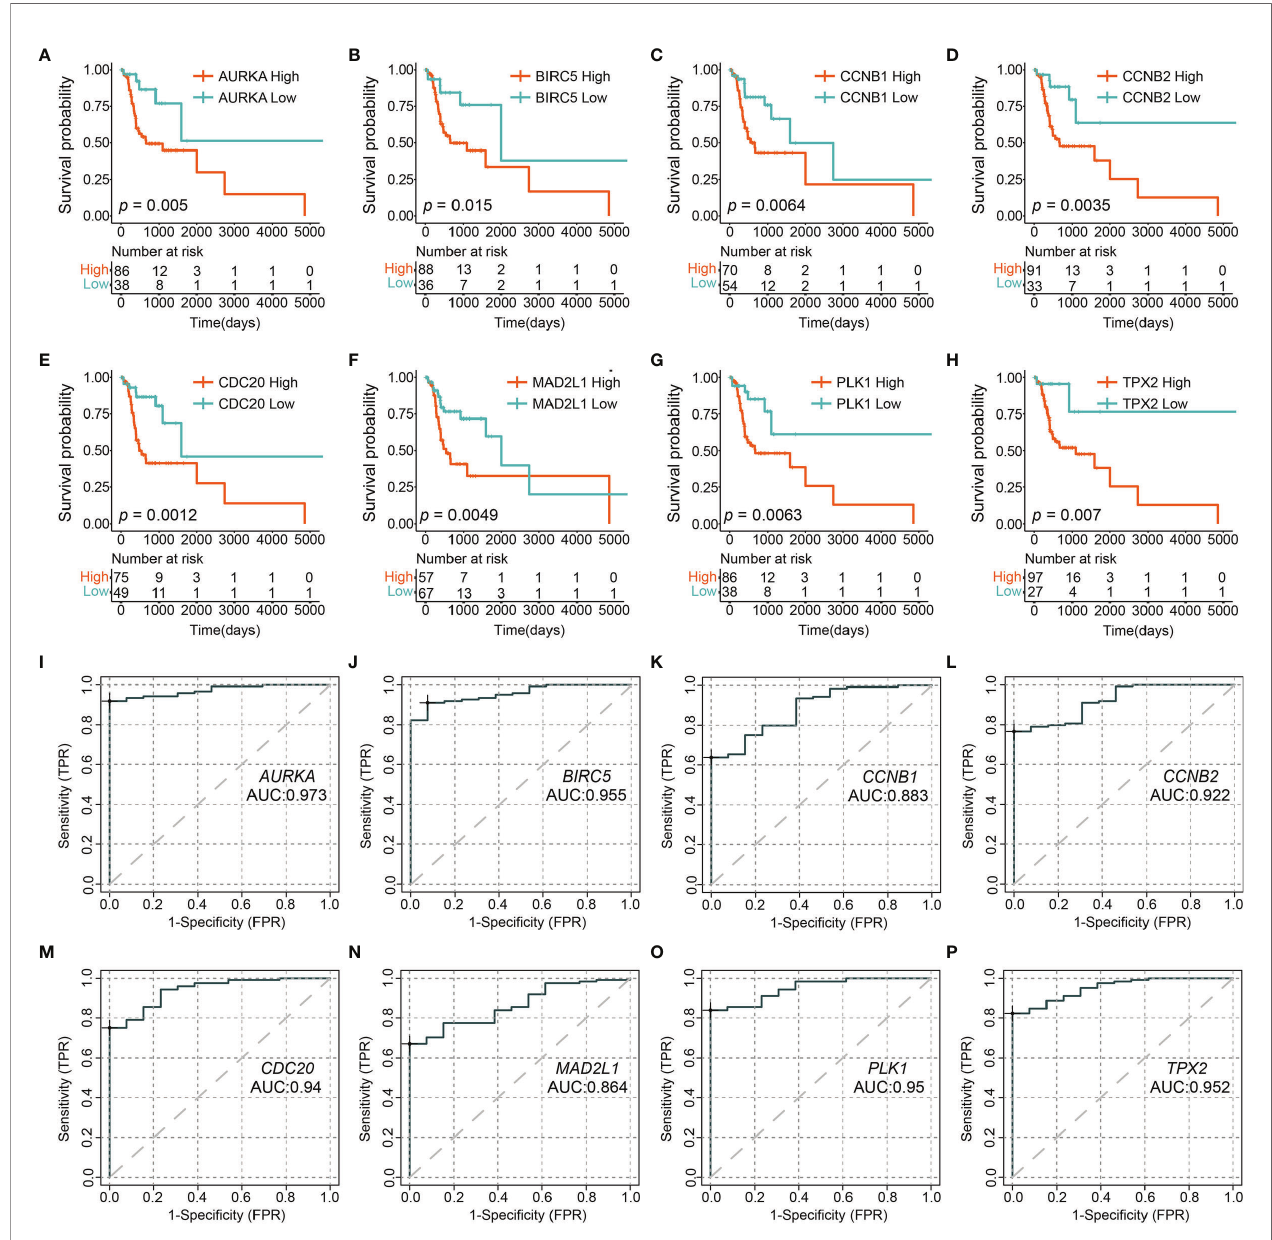
FIGURE 6 | Kaplan – Meier survival analysis (A – H) and ROC curve (I – P) of eight hub genes of